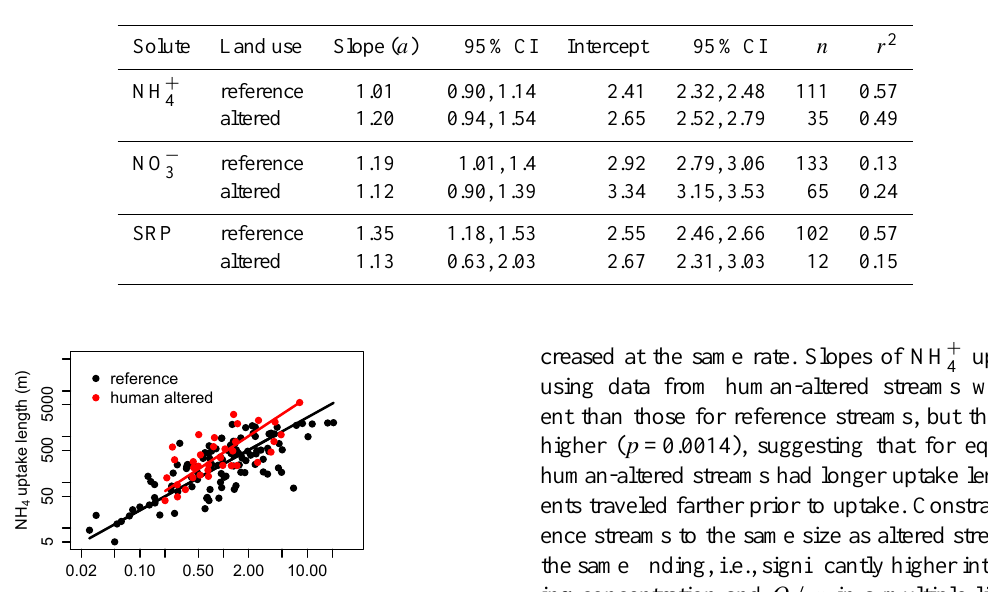
Table 1. Parameter estimates and statistics from standardized major axis regressions of log 10 uptake length ( S w ) vs. log 10 specific discharge ( Q/w ). CI is confidence interval, n is sample size, r 2 is goodness of fit.